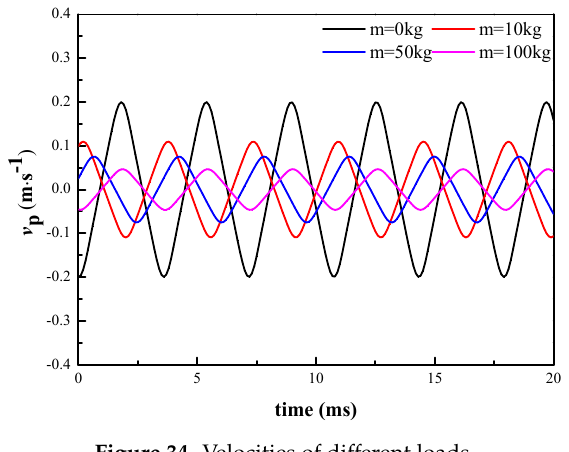
Figure 34. Velocities of different loads.